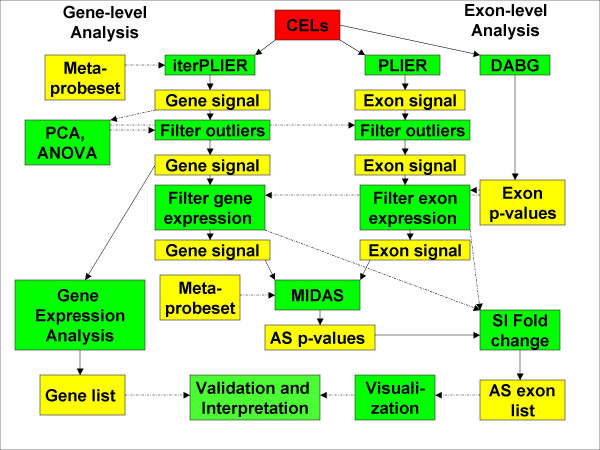
Workflow for parallel gene-level and exon-level analyses. The workflow illustrates two parallel lines of analysis corresponding to gene-level (left) and exon-level (right) signal processing. The analyses converge at the level of MIDAS or the Splicing Index, which implement statistical testing for alternative splicing. Signal estimation and MIDAS occur within the ExACT software and the filtering is accomplished mainly with simple Perl scripts. Yellow boxes represent files or data sets and green boxes represent processes or programs. Solid lines represent the main data flow and dotted lines are auxiliary flows, mainly for filtering.